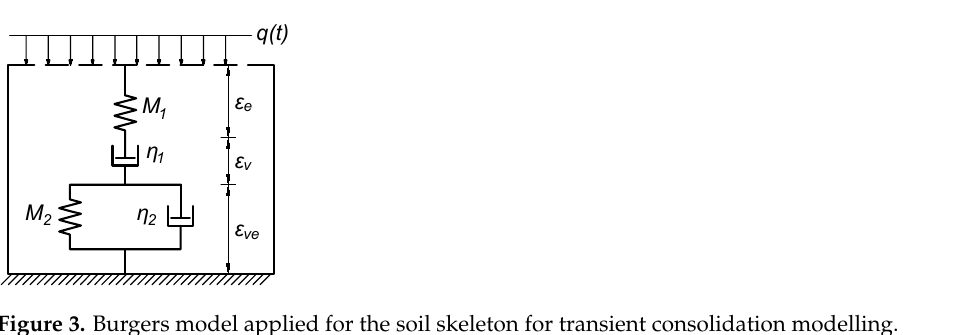
Figure 3. Burgers model applied for the soil skeleton for transient consolidation modelling.